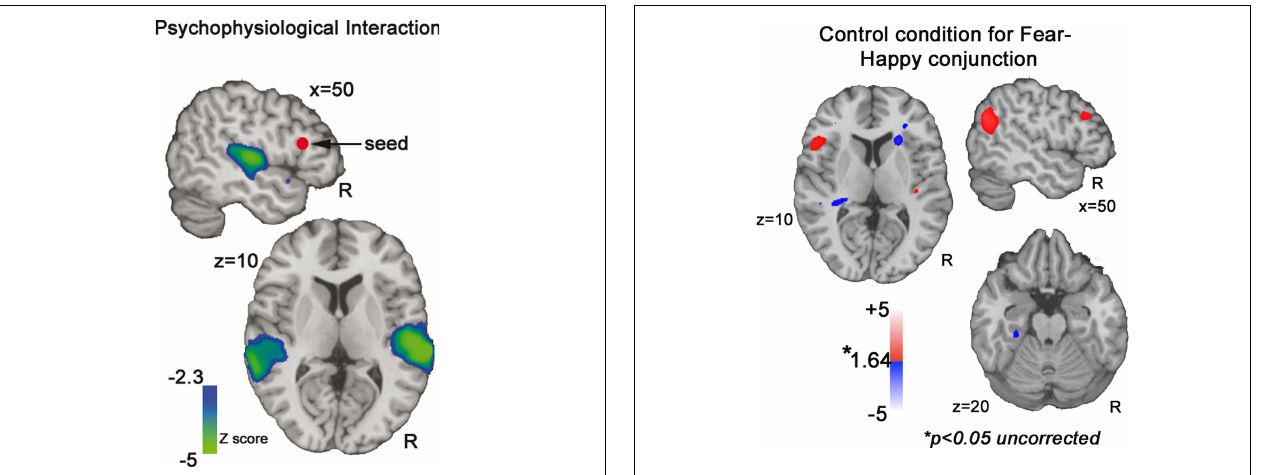
FIGURE 6 | Psychophysiological (PPI). This functional connectivity analysis map illustrates the negative interaction between ZCUE and the mean timeseries of IFG seed region (red sphere). This map indicates that functional connectivity between IFG and auditory processing regions is signifi cantly modulated by cue saliency: Decreasing cue saliency increases IFG-STG functional coupling, while increasing cue saliency decreases this coupling.